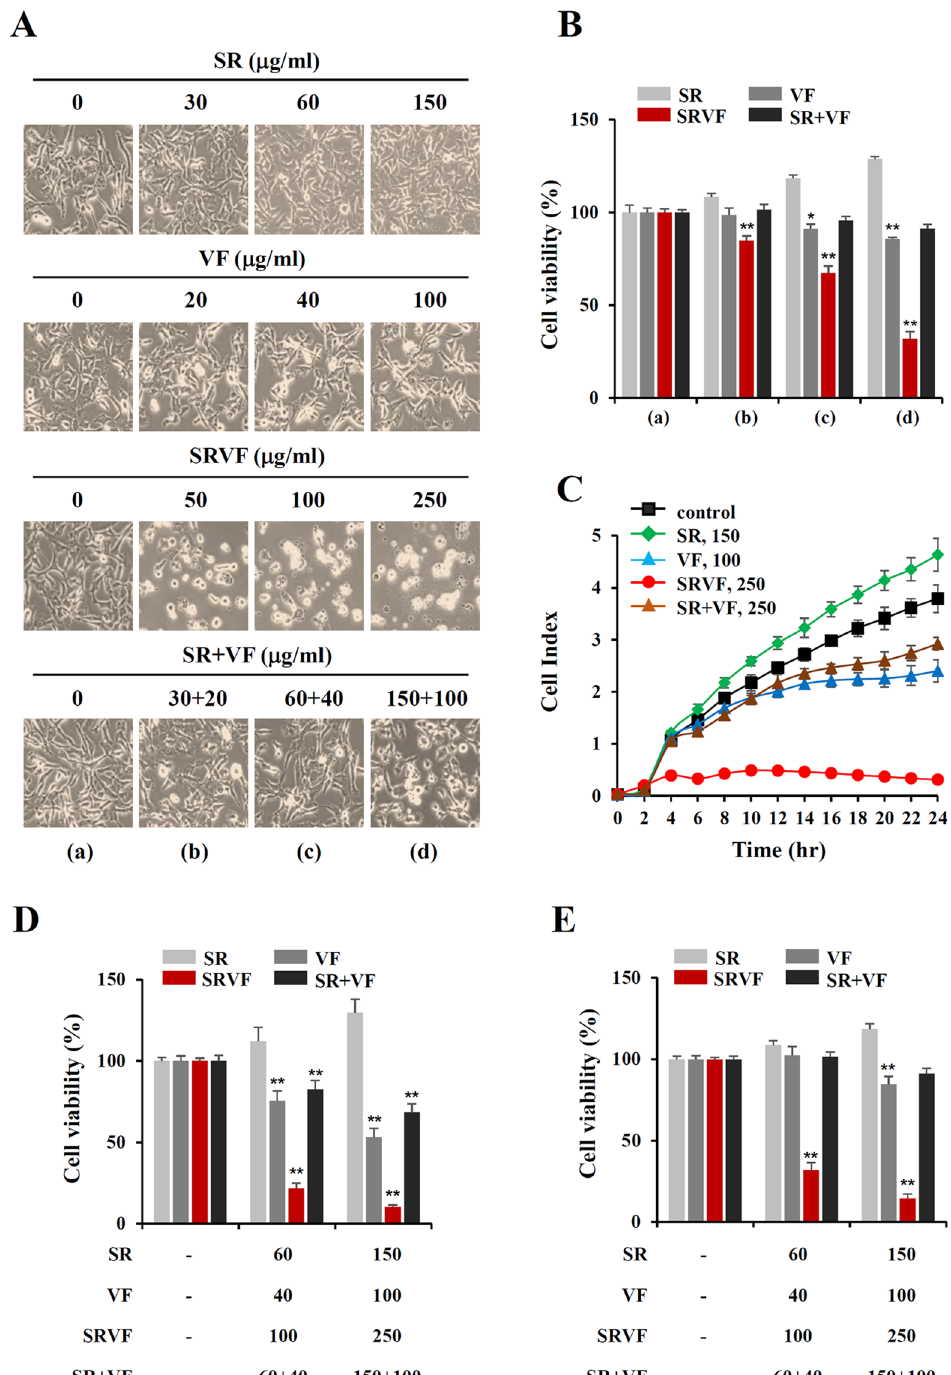
Figure 1. SRVF dramatically alters cell morphology and decreases cell viability in malignant cancer cells. ( A ) HT1080 cells were incubated with the indicated doses of SR, VF, or SRVF at concentrations of 50, 100, or 250 µ g/ml for 24 h and photographed at a magnification of × 200 under an inverted microscope. ( B ) Cell viability after incubation with SR, VF, or SRVF was determined using the CCK assay and is expressed as the mean ± standard deviation (SD). ( C ) Cells were seeded onto the E-Plate 16, treated with SR, VF, or SRVF at a concentration of 250 µ g/ml, and cell proliferation was monitored using the xCELLigence system. Data are representative of two independent experiments performed in triplicate and are expressed as the mean ± SD. ( D , E ) The effects of SR, VF, or SRVF on cell viability of MDA-MB231 ( D ) and HepG2 ( E ) cells were evaluated by the CCK assay and are expressed as the mean ± SD. Statistical significance was determined with Student’s t -test. * p < 0.05, ** p < 0.05 vs. untreated